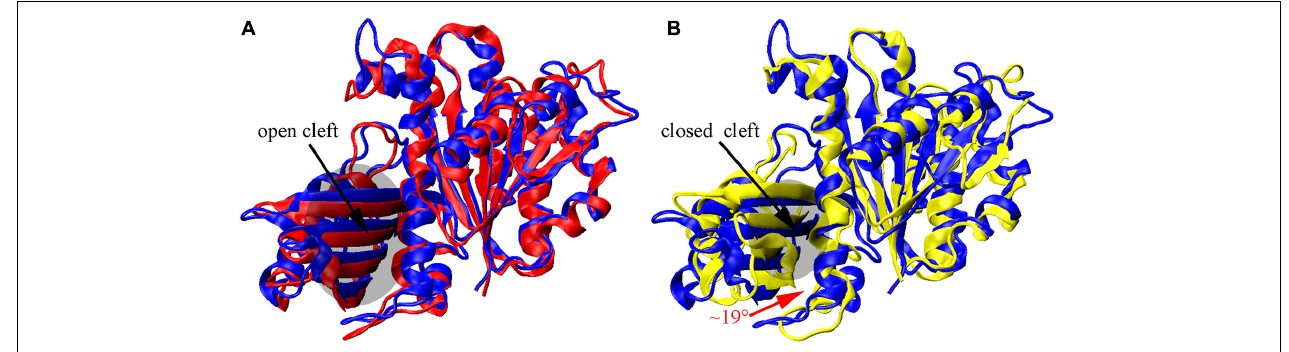
FIGURE 8 | Nucleotide-regulated subunit conformational changes. (A,B) superimposition of the N-terminal domain of the initial T structure (blue) on monomeric structures obtained by averaging over all three subunits from the final 10 ns GTP- (red) and GDP-bound (yellow) simulations. The inward rotation of the C-terminal domain is indicated by the red curved arrow in (B) .